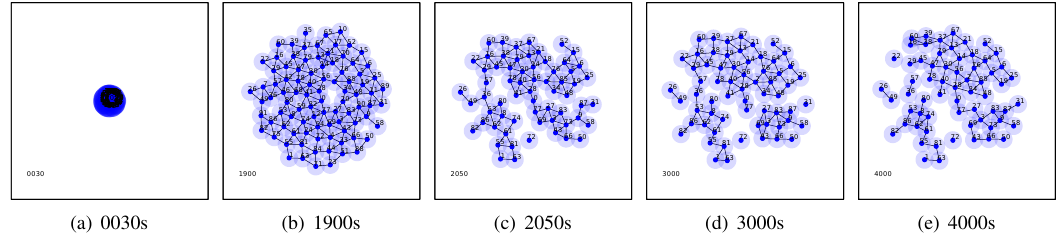
Fig. 11: RSR algorithm developed by Razafindralambo and Simplot-Ryl (2011). Deployment snapshots with 30% of node disappearing at 2000s and the self-healing